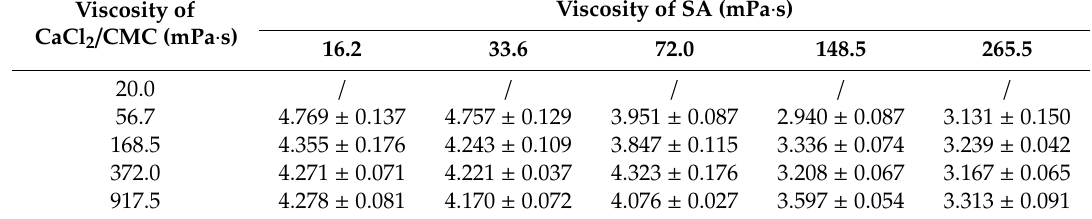
Table 2. E ff ects of viscosities of SA and CaCl 2 / CMC solution on D (mm) of the mm-CaSA-Caps.